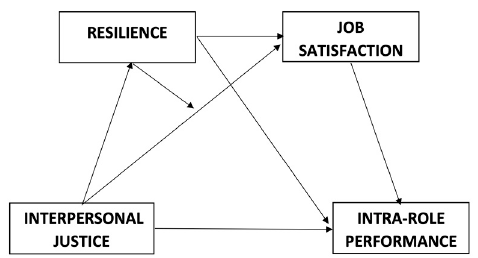
Figure 1. Research Model.